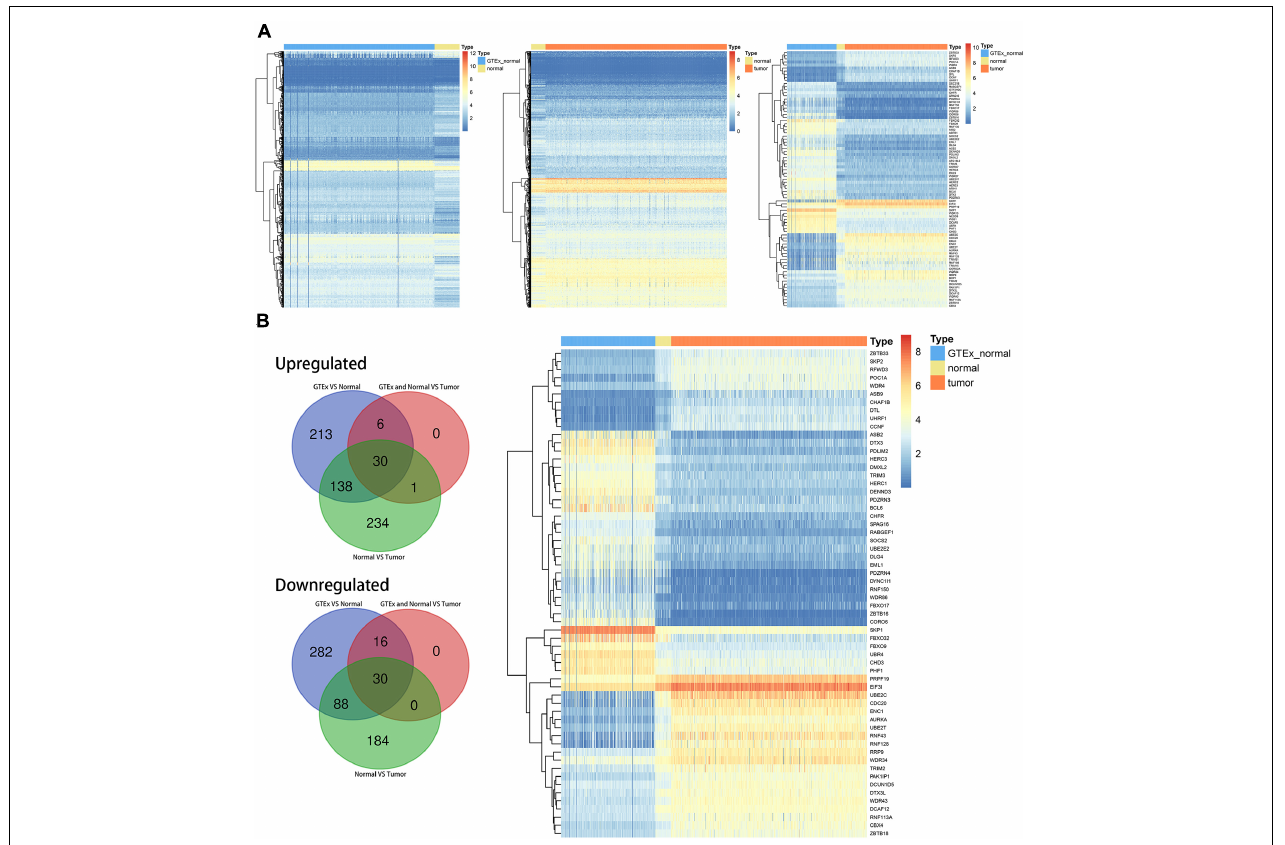
FIGURE 2 | Differentially expressed ubiquitin (Ub)–proteasome system (UPS)-associated genes in colorectal cancer (CRC). (A) Heatmaps depicting the expression landscape of differentially expressed UPS-associated genes in three comparative groups. (B) Numbers of intersected differentially expressed UPS-associated genes in three comparative groups (left panel) and the expression pattern of 60 differentially expressed UPS-associated genes in three subgroups of datasets (right panel).